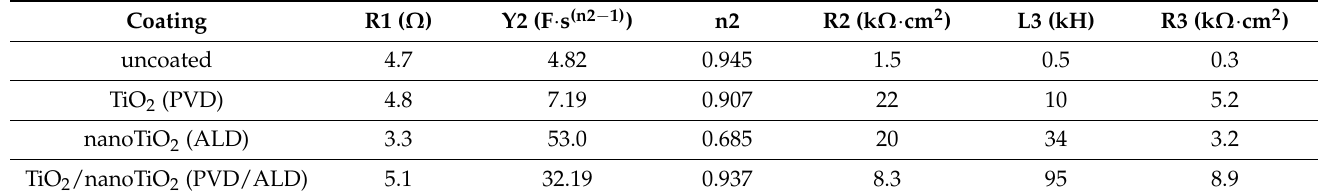
Table 3. Electrical equivalent circuit values of the investigated